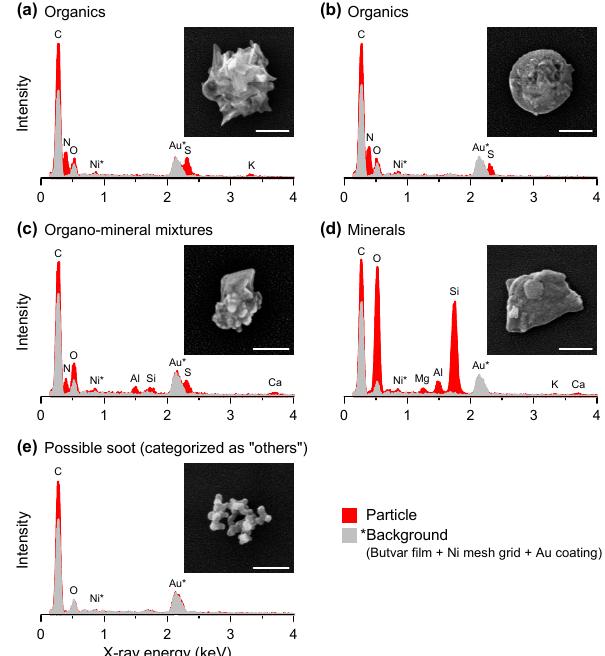
Figure 4. Exemplary SEM/EDX images of sugar beet soil dust par- ticles. (a) Organic particle (crystalline-shape type). (b) Organic par- ticle (amorphous-shape type). (c) Organo–mineral mixture particle. (d) Mineral particle. (e) Soot-like particle. The SEM/EDX images were acquired after Au coating. Scale bars, 300nm. Red X-ray spec- tra show the elemental composition of each particle, and grey X-ray spectra represent the background signal caused by a Butvar film supported by Ni mesh grids and Au